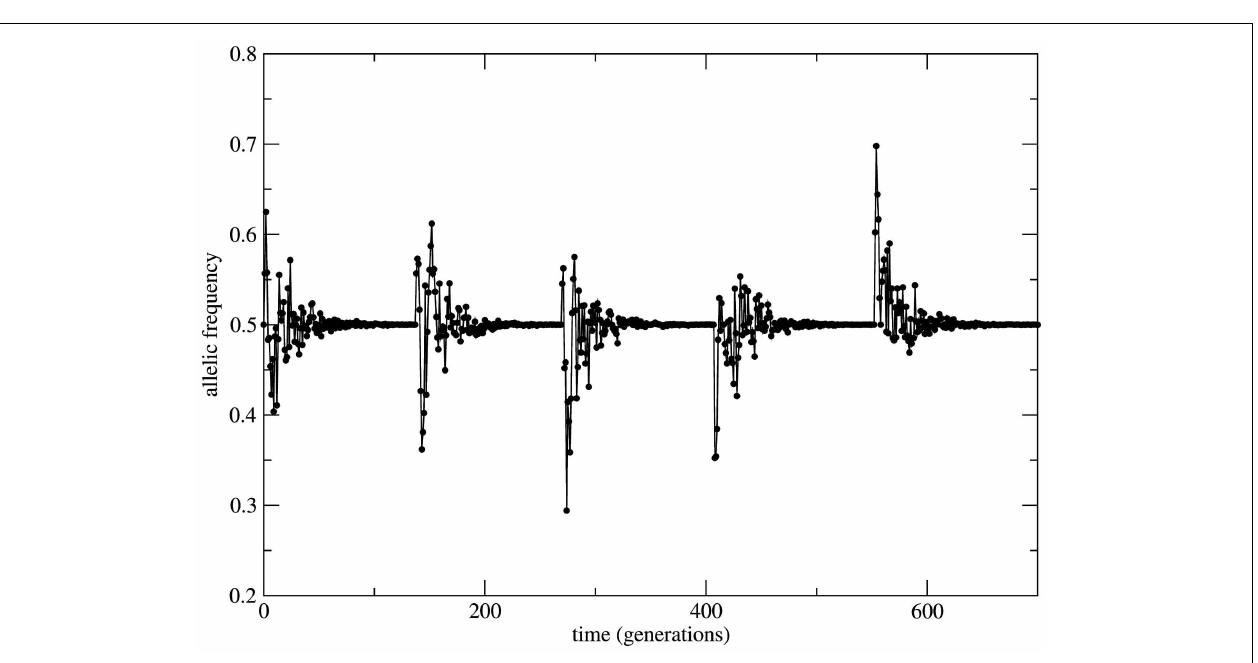
approximately 100 generations and then the allele frequency stabilizes at f a = 0.5.The subsequent bottleneck events imposed to the population shows the robustness of the transient size and of the asymptotic value of the allele frequency due to stable character of the